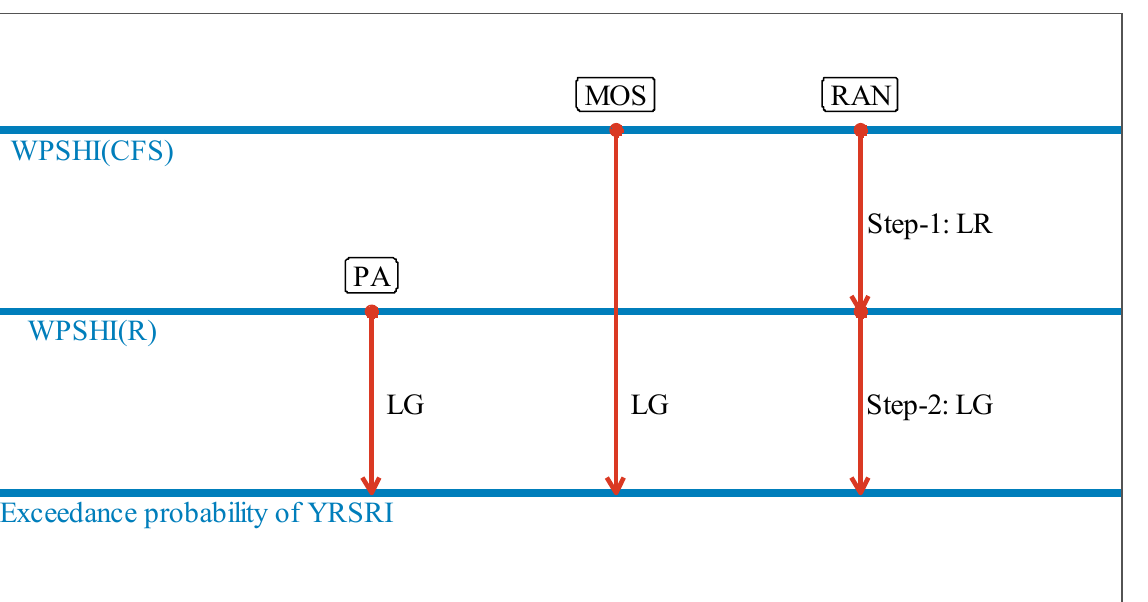
Figure 6. Three test procedures explored in this study for YRSRI. In the figure, LG means logistic regression and LR means linear regression. For predicting streamflow, the procedures are similar with what have been shown in this figure, and the only difference is that the antecedent streamflow is used as another predictor for forecasting the exceedance probability of streamflow.